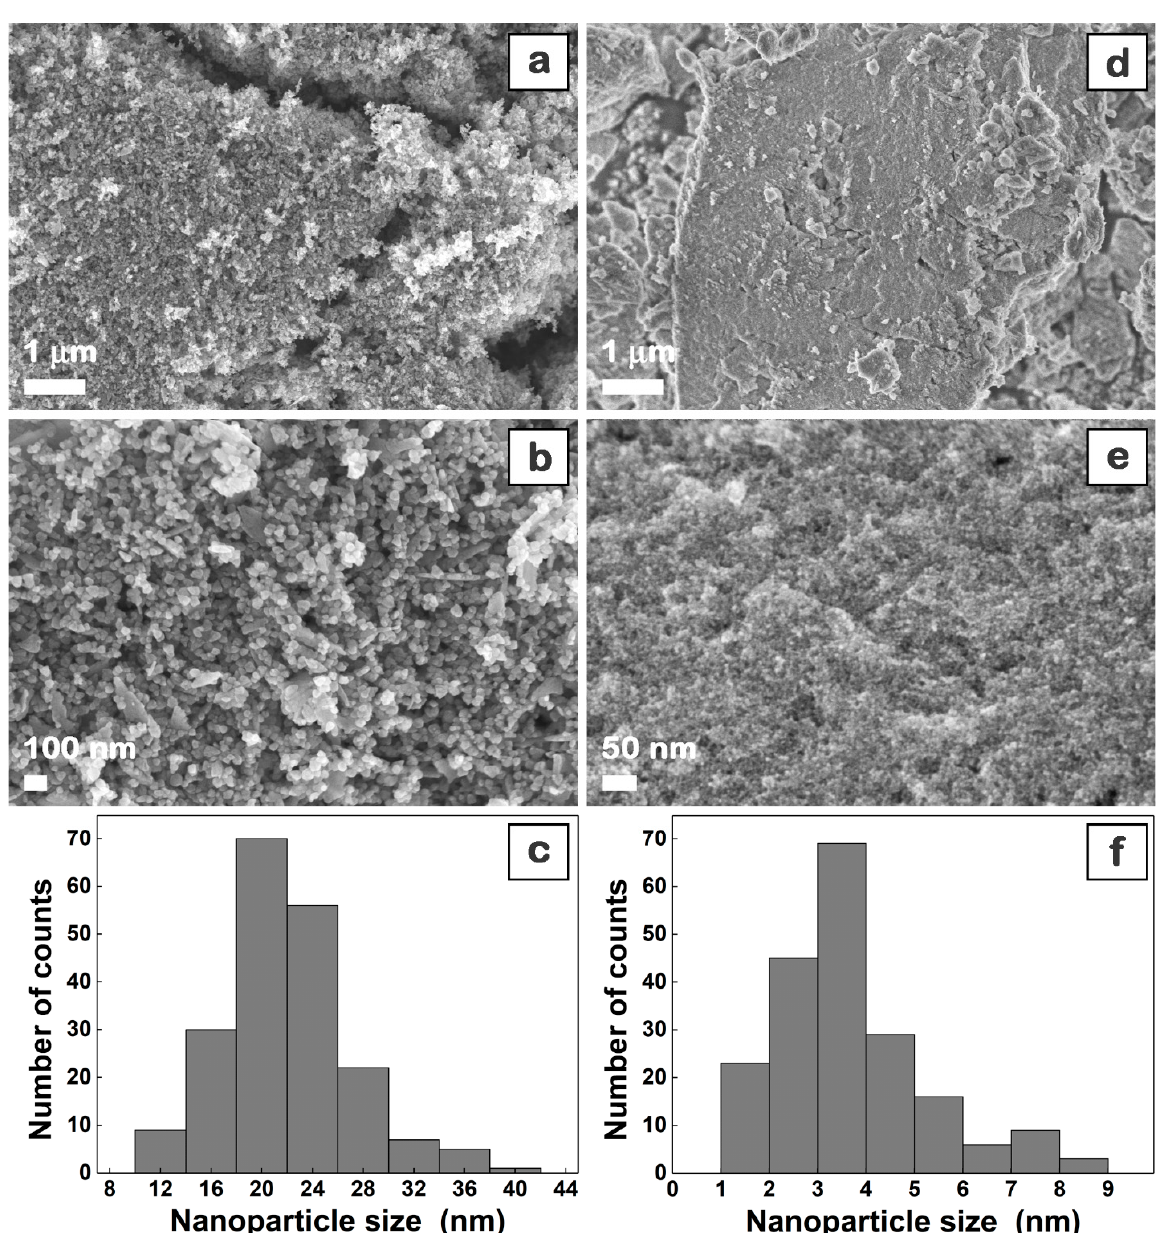
Figure 1. FESEM images (at two magnifications) and particle size distribution histograms of the chemically synthesized ZnO ( a – c ) and CuO ( d – f ) nanoparticles.